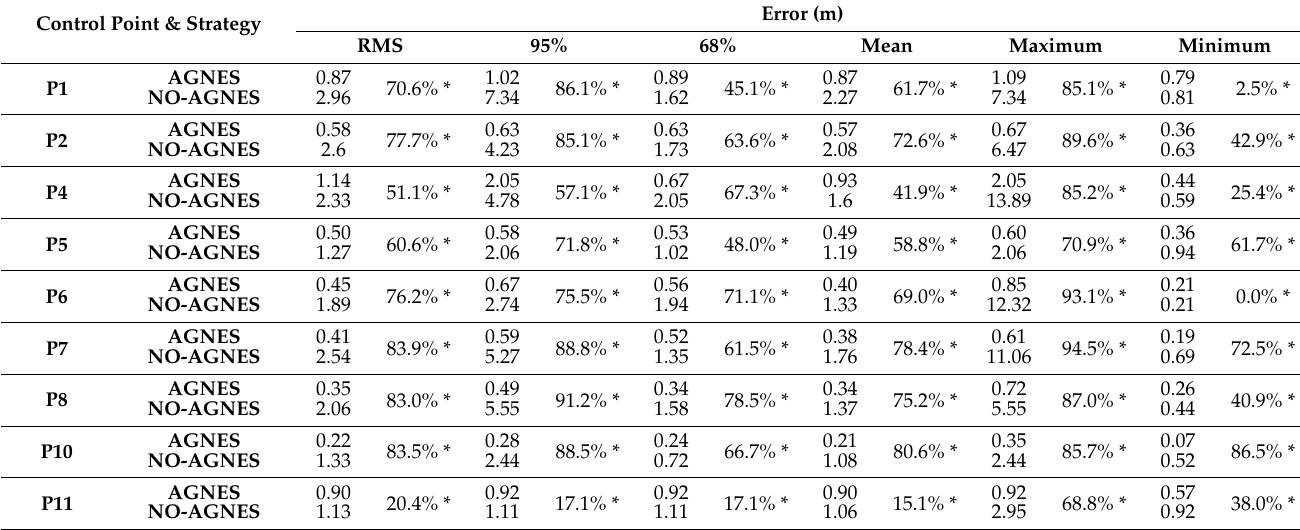
Figure 11. CDF for the evaluated 9 control points. ( a ) P1; ( b ) P2; ( c ) P4; ( d ) P5; ( e ) P6; ( f ) P7; ( g ) P8; ( h ) P10; ( i ) P11. Table 2. Various statistical results for the evaluated 9 control points.